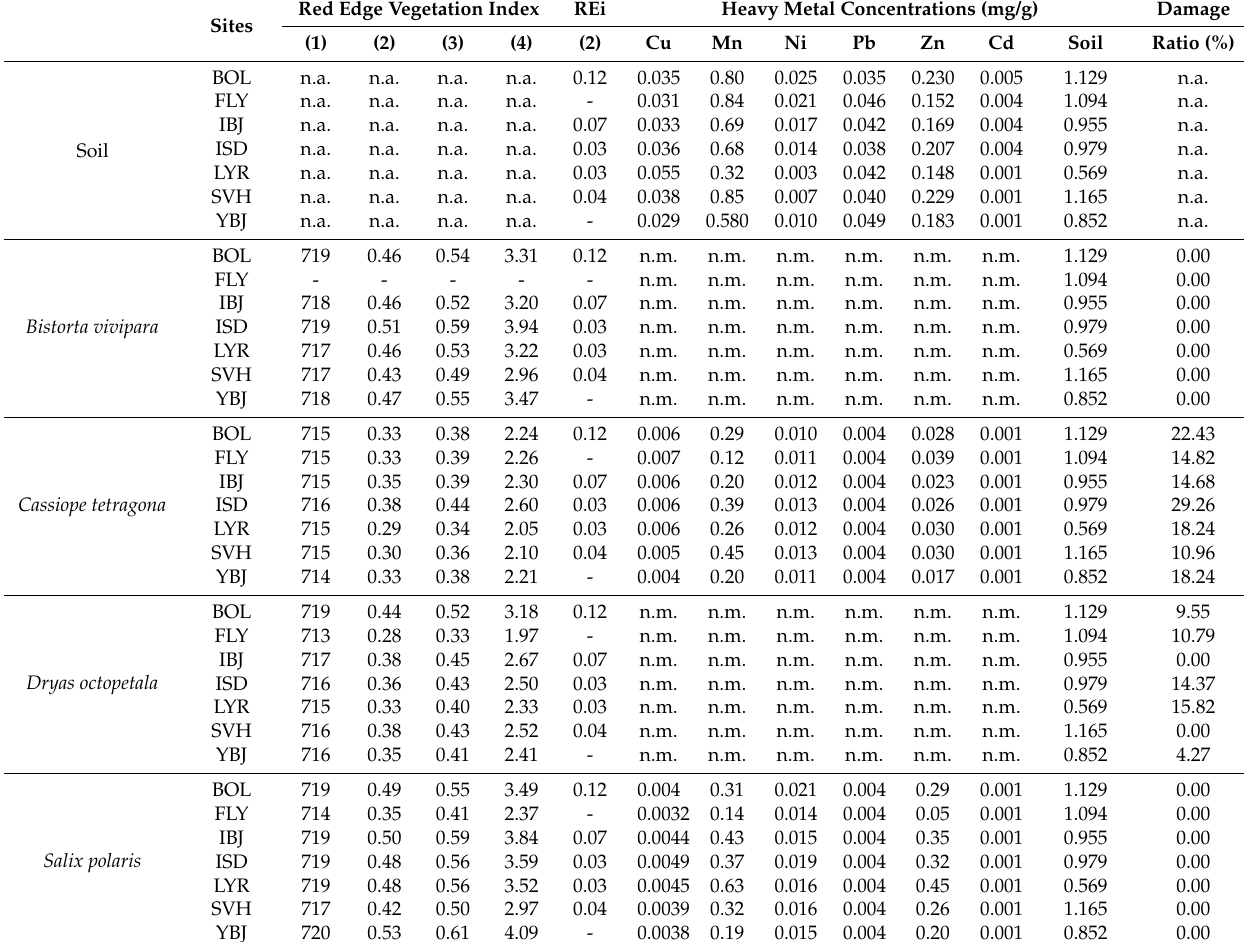
Table 8. Calculated red edge vegetation indices from ASD FieldSpec and the RapidEye image (REi) as well as the heavy metals concentrations (mg/g) in plants and soil. Column headings: (1)—REPI (nm), (2)—RENDVI, (3)—MRENDVI, (4)—MRESR. Damage ratio – percent of damaged plants. n.a. = not applicable, n.m. = not